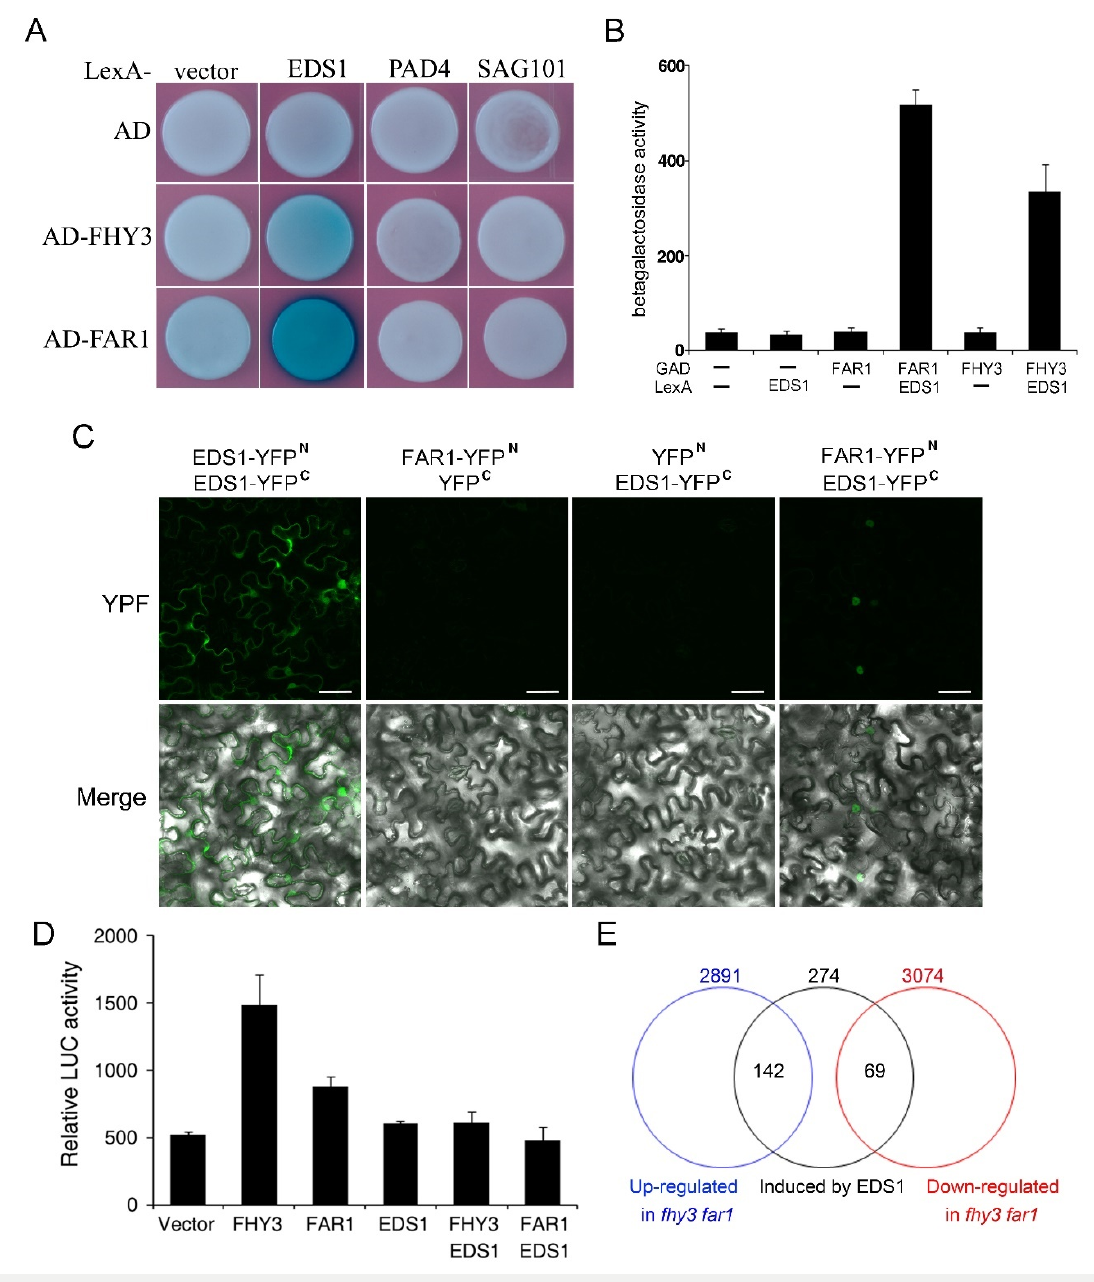
Figure 8 Interaction between FAR1 and EDS1. ( A ) Yeast two-hybrid assay showing the interaction between LexA- and AD-fused proteins. Growth of blue yeast cells indicates an interaction between the two proteins. ( B ) Quantification of yeast two-hybrid interactions by determining β -galactosidase activity. Bars indicate the SD of six individual yeast colonies. ( C ) BiFC assay showing that YFP N -FAR1 and EDS1-YFP C interact to reconstitute a functional yellow fluorescence protein (YFP) in the nucleus (indicated by arrows) of Nicotiana benthamiana leaves. Bar: 50 µ m. ( D ) Transient expression assay of SID2p:LUC in N. benthamiana . Relative LUC activity was normalized to the 35S:GUS internal control. Bars indicate the SD of three replicates. ( E ) Venn diagrams showing the overlap of differentially regulated genes in fhy3 far1 with previously reported EDS1-induced genes (Bartsch et al., 2006).